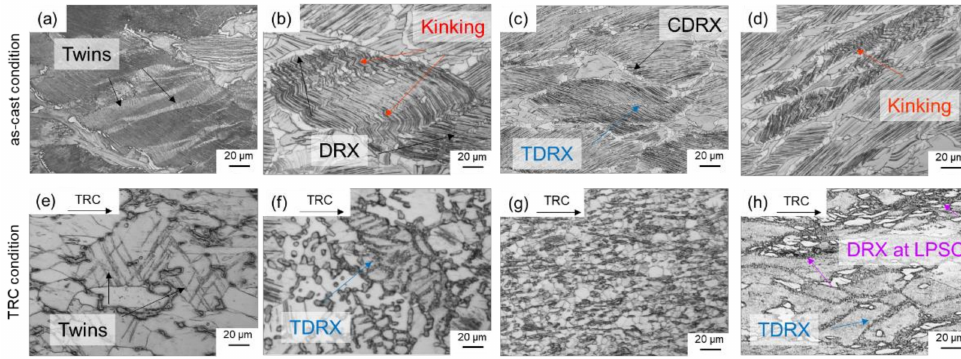
Figure 10. Optical micrographs of the deformed samples after conventional casting ( a – d ) and TRC ( e – h ) showing different deformation and recrystallization mechanisms.